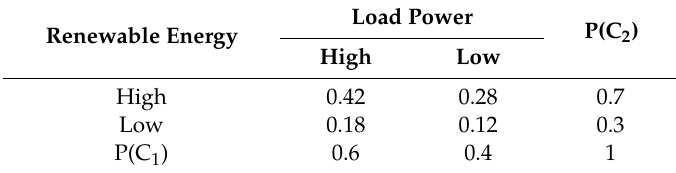
Table 9. Standardized indicators matrix for generation expansion planning decision-making.